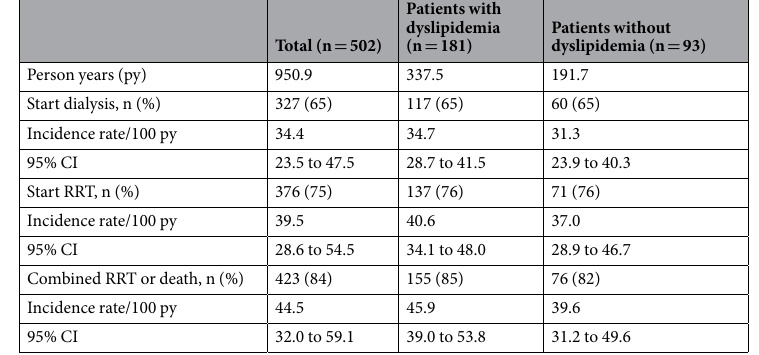
Table 2. Crude incidence rates (95% CIs) of primary outcomes according to the presence of dyslipidemia (n = 502). CI: confidence interval, n: number, py: person year, RRT: Renal Replacement